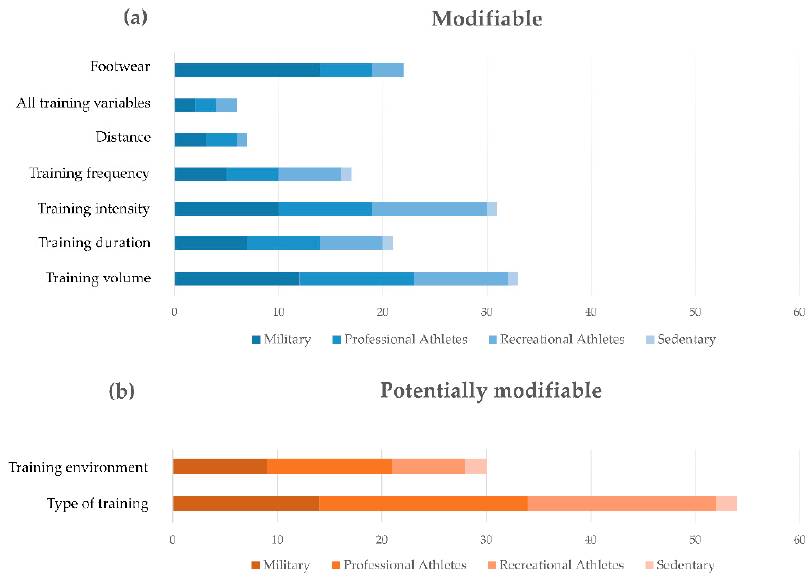
Figure 8. Reviewed articles regarding modifiable ( a ) and potentially modifiable ( b ) extrinsic risk factors according to the investigated population.